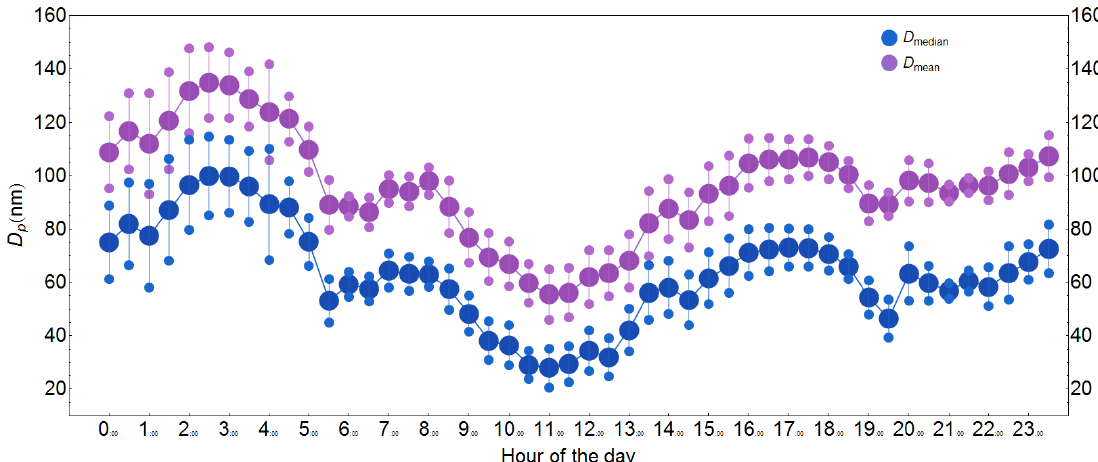
Figure 4. Daily trends of mean and median diameters of particles evaluated throughout the measurement